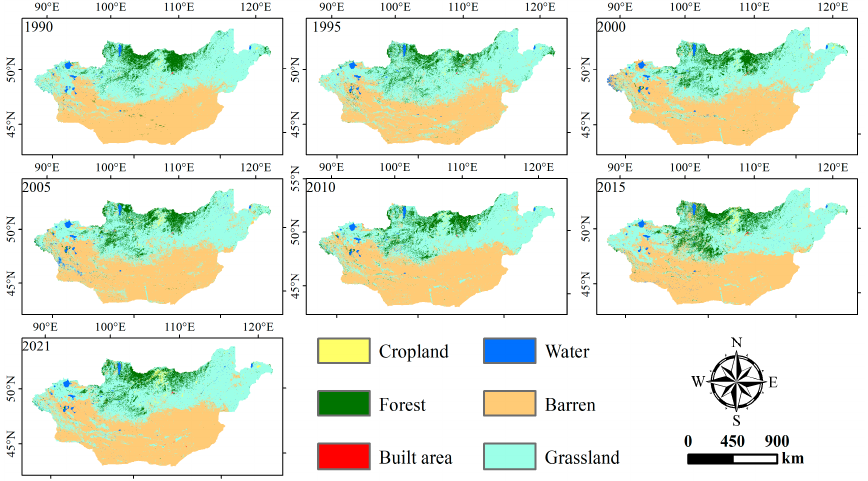
Figure 5. Spatial distribution of land use type in Mongolia from 1990 to 2021. To intuitively reflect the spatial characteristics of LUCC, we used the grid calculator of ArcGIS to calculate the spatial distribution map of mutual transformation between dif- ferent land use/cover. The land use change pattern in Mongolia from 1990 to 2021 is shown in Table 3 and Figure 6. We estimate that 27.5 × 10 4 km 2 of the land surface in Mongolia, accounting for 17.6%, changed at least once among the six land categories from 1990 to 2021. The grassland, water, cropland, and built areas exhibited a growing trend, while the barren land and forest areas decreased. Among all types, the amplitude of land use change was the smallest for forest land and the largest for built areas. The area of barren land decreased by 6.2 × 10 4 km 2 , mainly in central Mongolia. The forest area decreased by 0.5 × 10 4 km 2 , mainly in the Selenge Valley in northern Mongolia. Meanwhile, grassland and water area increased. The grassland increased by 6.6 × 10 4 km 2 , mainly in eastern Mongolia. The water area increased by 1007 km 2 , which was mainly related to the changed area of lakes on the plateau. The area with the least amount of change was the built area, but it increased dramatically from 499 km 2 to 1242 km 2 , representing approximately twice the growth rate of the other areas. On the time scale, taking 2005 as the boundary, the barren area first showed an increasing and then decreasing trend. In addition, compared to 1990, the increase in barren land mainly occurred in the East Govi and North Donogovi provinces. The change in the grassland area first showed a decreasing and then increasing trend, and the increase in grassland mainly occurred in northern Mongolia, particularly in the Selenge prefecture.